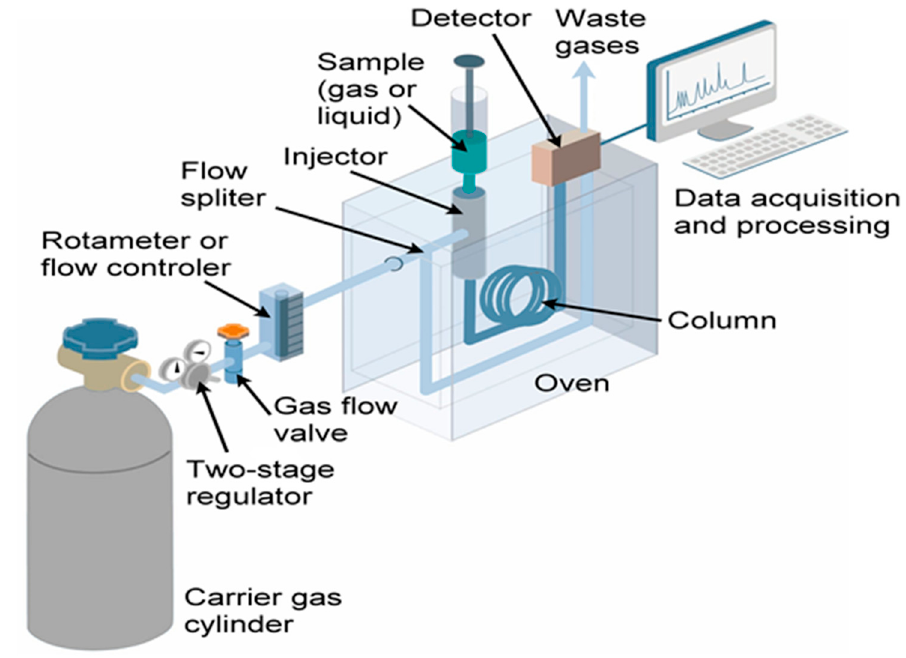
Figure 18. Laboratory scale GC-Detector system is shown schematically. Adapted from